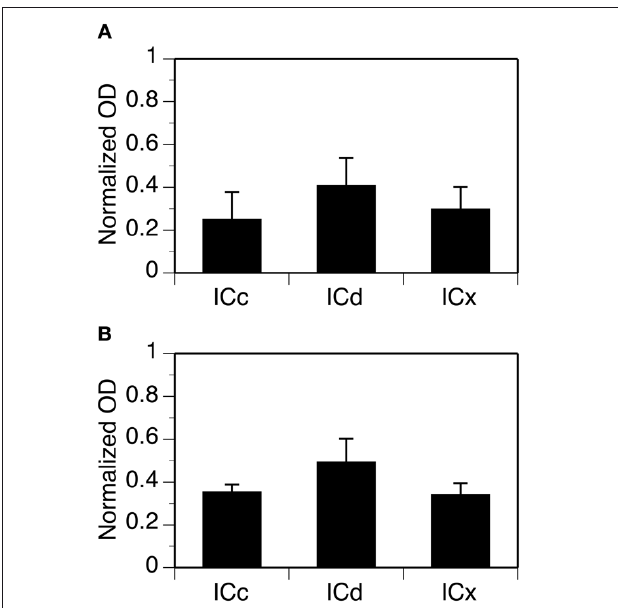
FIGURE 12 | Group results showing levels of GABA B R1 (A) and GABA B R2 (B) immunoreactivity in the neuropil in three subdivisions of the IC. For each section in an animal, normalized OD was obtained for each of the alternating grid boxes. A mean normalized OD value was obtained for each collicular subdivision. Each bar in a bar chart represents a grand mean value for four animals for a subdivision. Error bars indicate standard